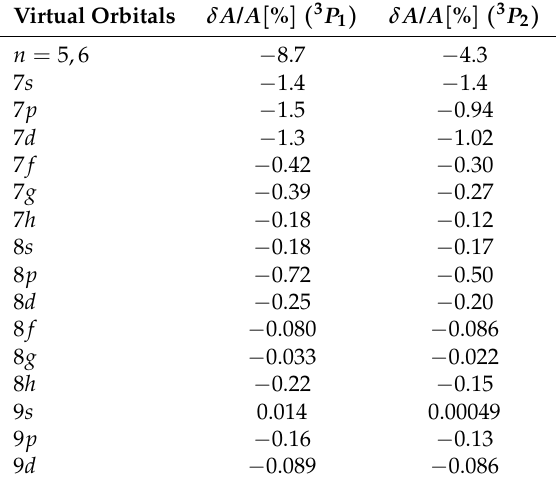
Table 4. Relative changes in the hyperfine constant A from the preceding calculation as the virtual orbitals were included in the order n = 5,6, 7 s . . . 7 h etc. for cc substiutions from 5 spd . Virtual Orbitals δ A / A [ % ] ( 3 P 1 )